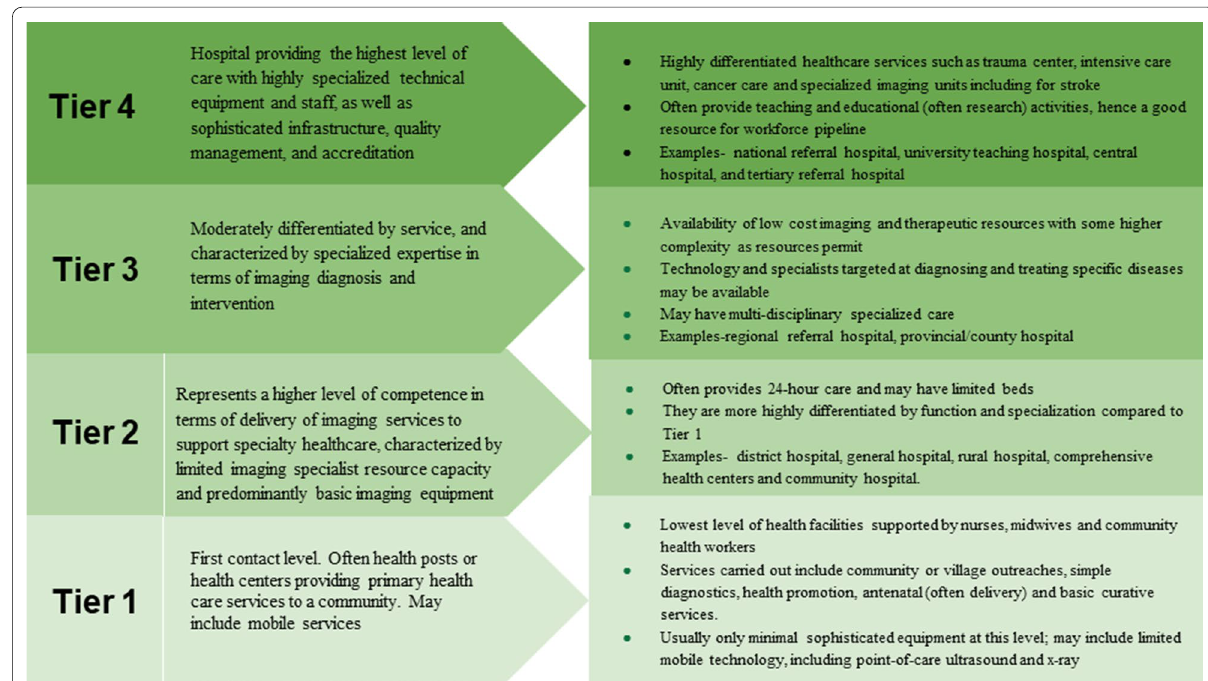
Fig. 1 Tiers and levels of Health Systems. A darker color denotes a higher level of care with higher complexity and requirement for more specialized human and technological